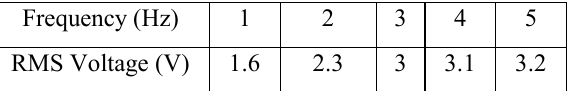
Table 1. RMS voltage obtained from a Piezoelectric diaphragm in different frequencies.